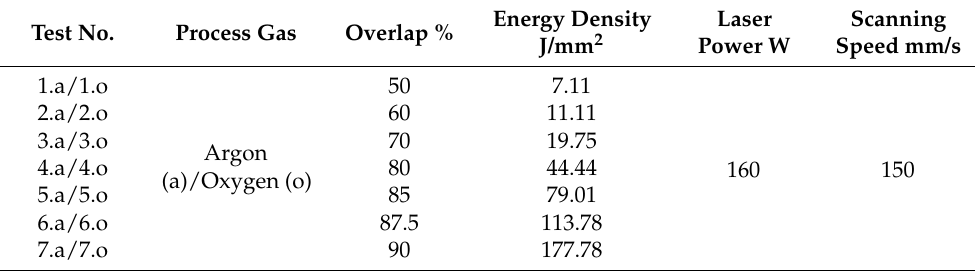
Table 2. Parameter plan for the overlap influence experiment.